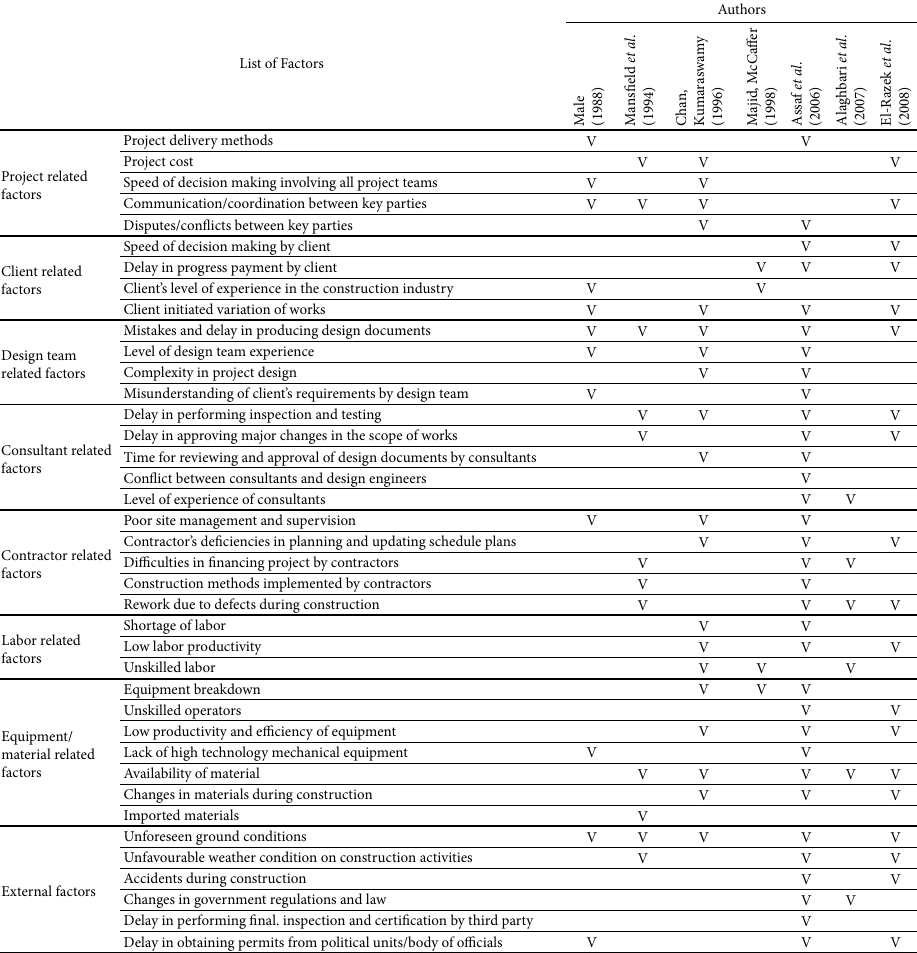
Table 1. Factors causing project schedule